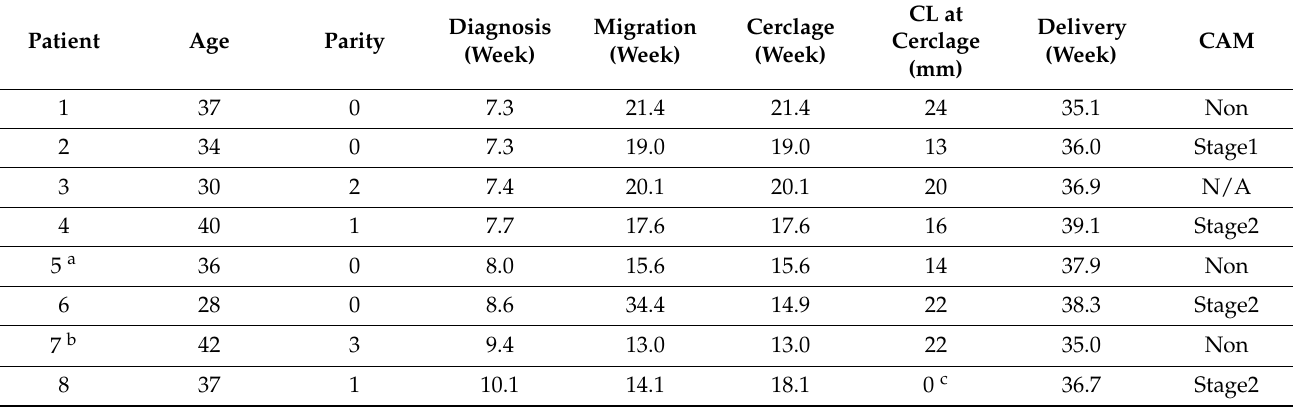
Table 3. Details of patients with decidual polyps treated with cervical